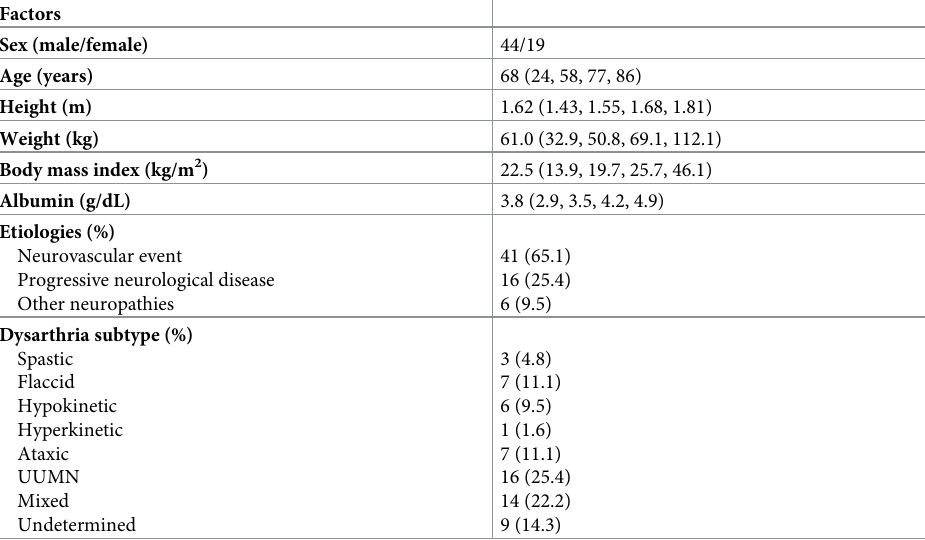
Table 1. Demographic information of speakers with dysarthria (n =